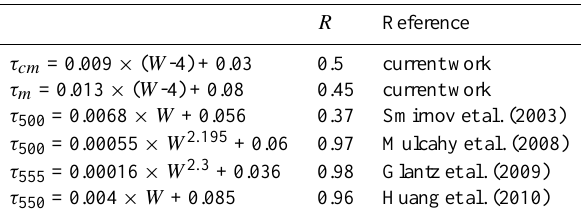
Table 1. Regression statistics of aerosol optical parameters versus surface wind speed.